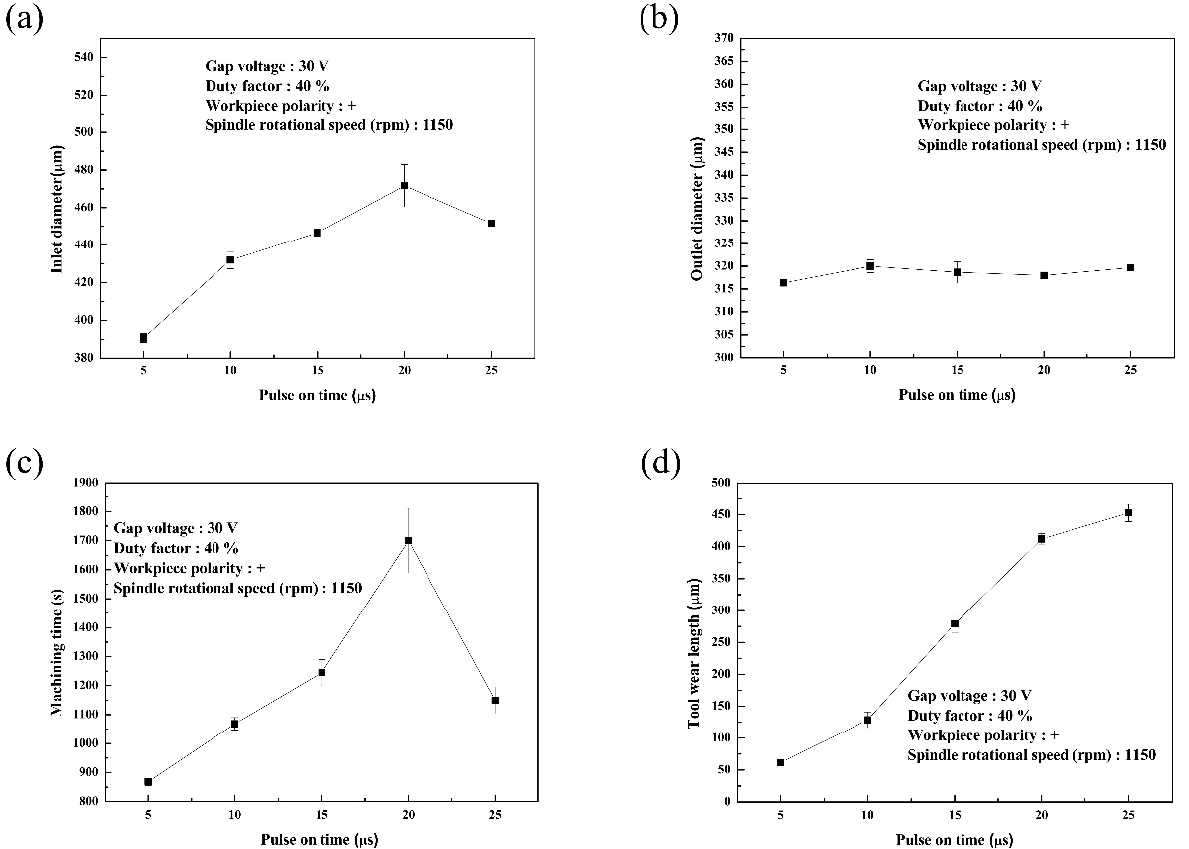
Figure 4. The relationship between pulse on time and ( a ) inlet diameter, ( b ) outlet diameter, and ( c ) machining time. ( d ) Length of electrode wear.